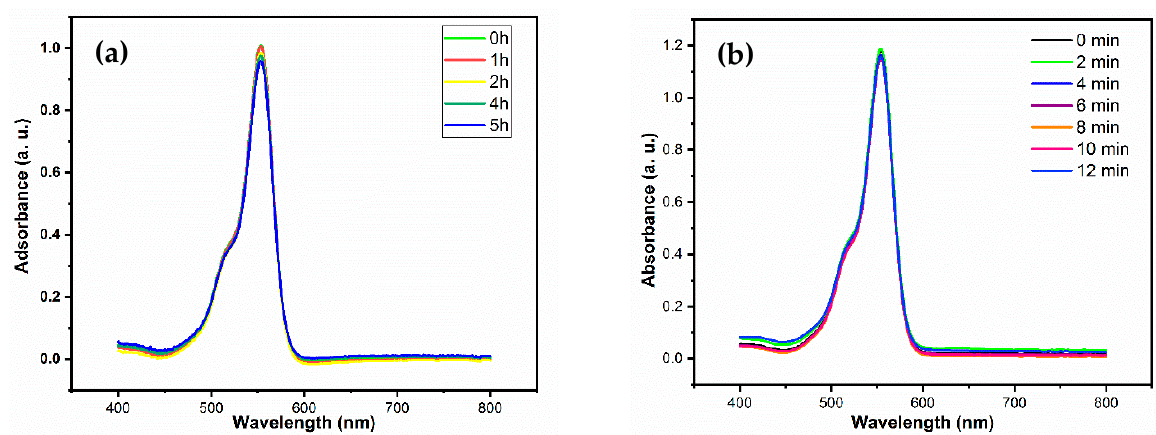
Figure 8. ( a ) Absorption spectrum of RhB in the presence of BiP particles and in the absence of UV irradiation; ( b ) photocatalytic degradation of RhB dye under UV light irradiation in the absence of the catalyst.